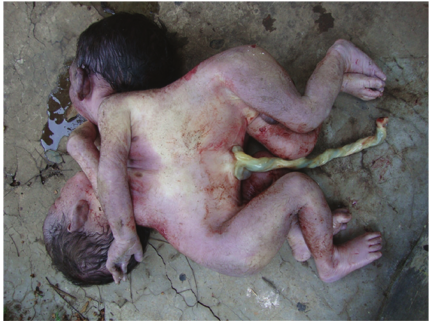
Figure 1: Photograph of babies joined at thorax.